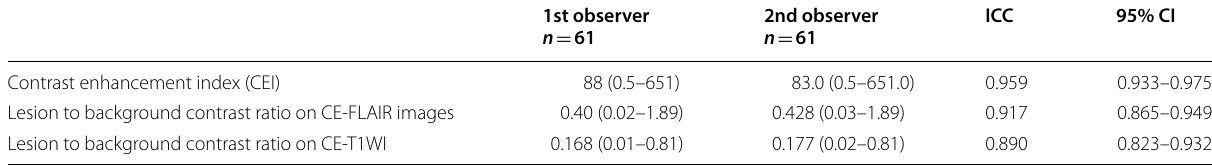
Table 4 Demonstrates interobserver agreement regarding the CEI and lesion to background contrast ratio on CE‑FLAIR and CE‑T1WI among studied cases